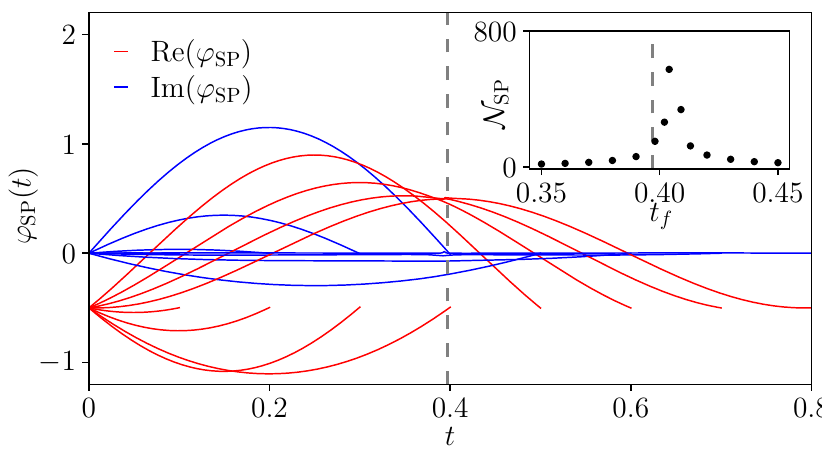
( t ) corresponding to the rate function Figure 5: Time evolution of the SP field ϕ SP λ ( t ) for a quantum Ising chain initialized in the |⇓〉 state and evolved with Γ = 8 J , dd f h = 0. The red and blue lines respectively show the real and imaginary parts of ϕ ( t ) for different end times t , where t corresponds to the point at which each f f SP curve terminates. In contrast to the case of local observables, the SP field shows a marked dependence on the end time. Notably, the SP field changes abruptly when the end time is chosen to be near the location of a DQPT at t ∗ ≈ 0.397 (vertical dashed line), with its real and imaginary parts changing sign. The inset shows that the number of iterations required to solve the SP equation sharply increases in N SP a region close to the